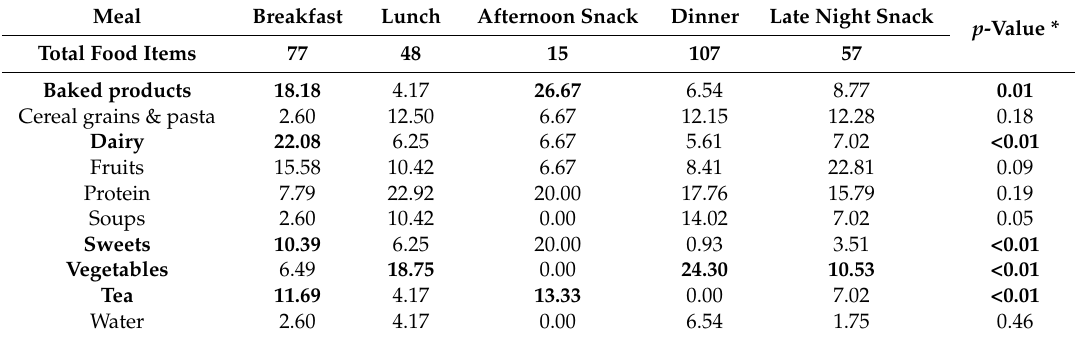
Table 2. The proportions of different food categories consumed in each eating occasion reported by 141 Turkish